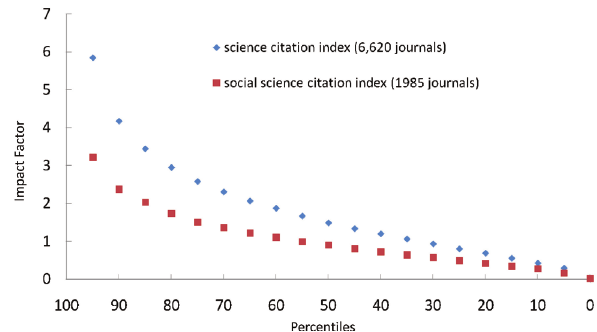
Figure 4 - Impact factor as a function of percentile distribution of the com- plete 2008 ISI Editions of JCR.